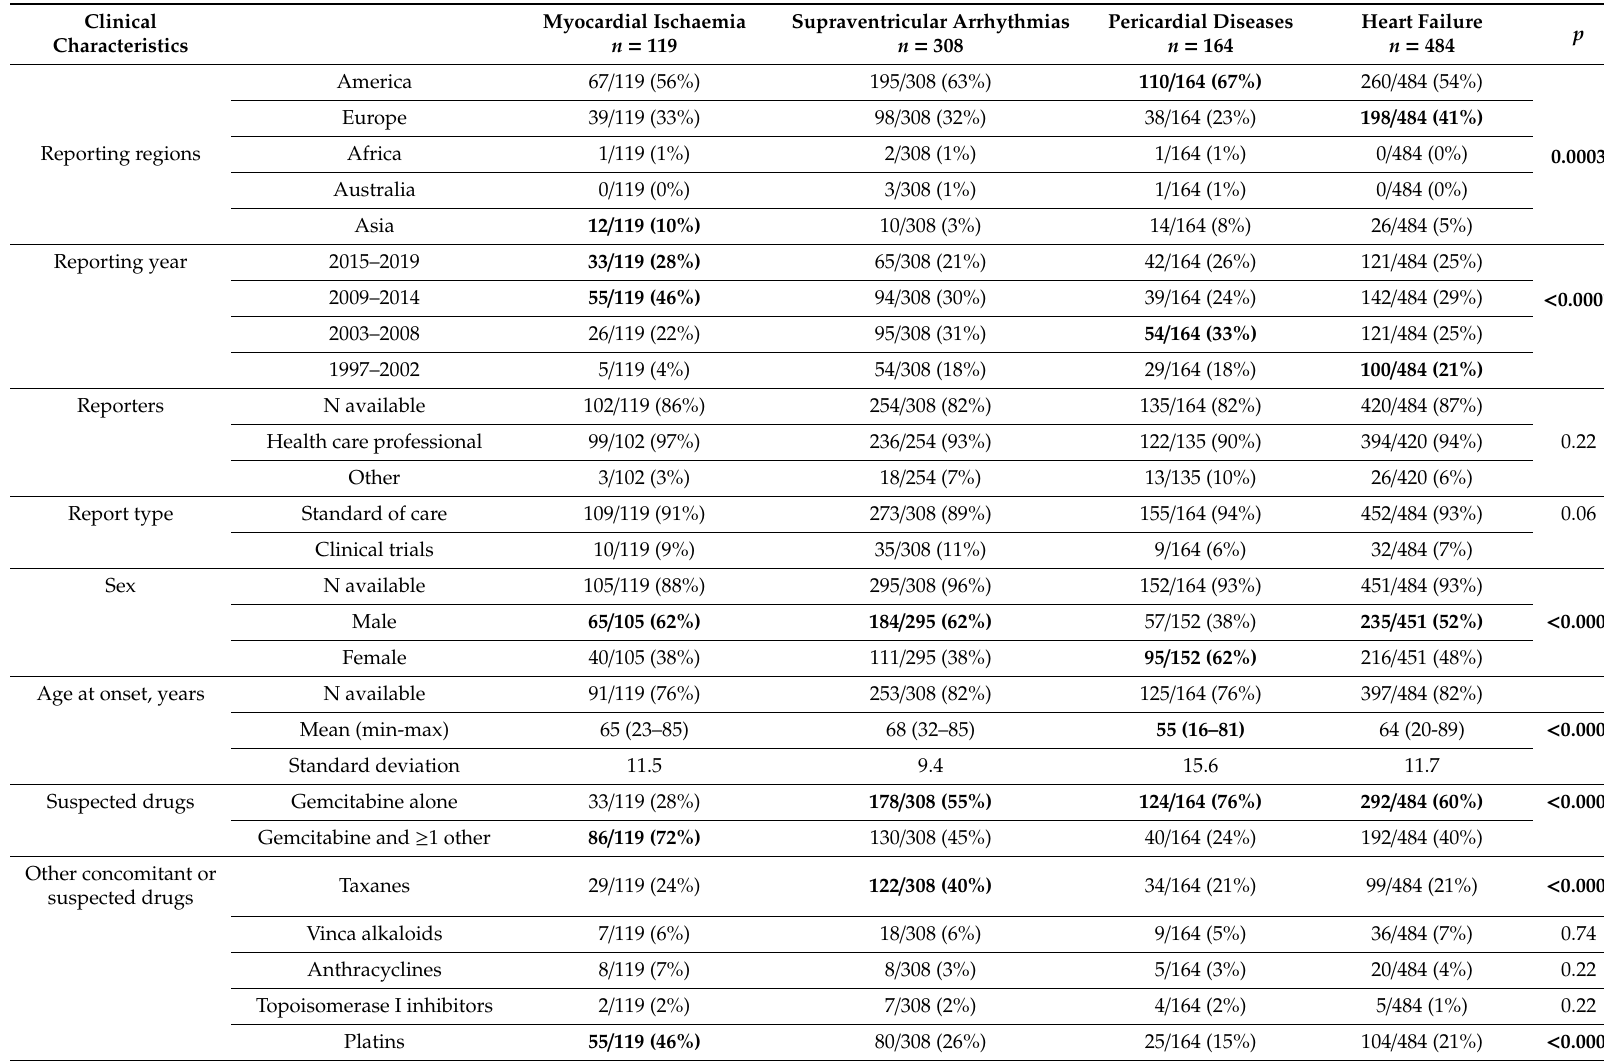
Table 4. Characteristics of patients with gemcitabine-associated cardiovascular adverse drug reactions (CV-ADRs) in VigiBase on 1 April 2019. Clinical